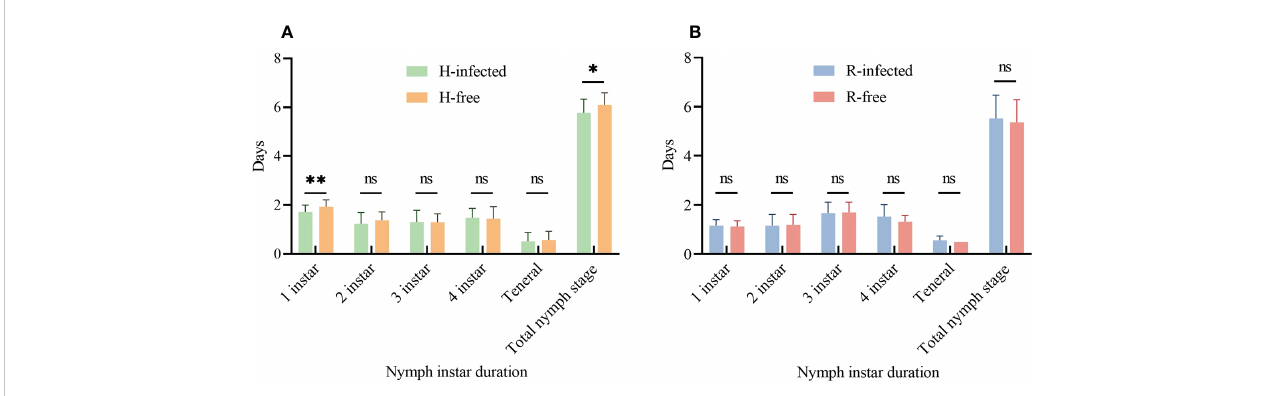
FIGURE 2 Aphid nymph instar duration of different aphid strains. (A) Nymph instar duration of H-infected and H-free aphid strains. (B) Nymph instar duration of R- infected and R-free aphid strains. The asterisk indicates signi fi cant differences based on the t -test for two-sample comparison: * P <0.05, ** P <0.01, and ns nonsigni fi cant.